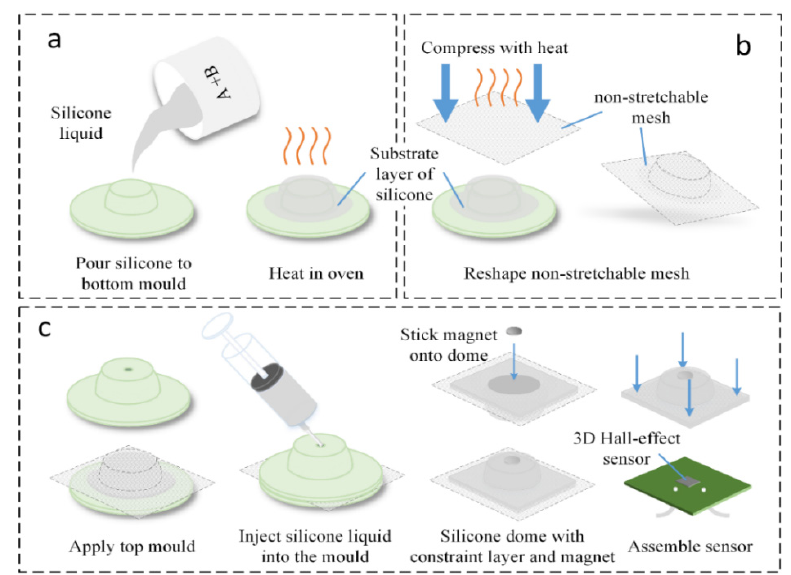
Figure 2. Fabrication of the soft sensor: ( a ) the bottom elastomeric layer is formed by pouring pre-polymer silicone rubber onto the bottom mold and then curing by heating in oven at 45 ℃ for 15 min. ( b ) Thermal pre-shaping of the inextensible strain-limiting fabric layer. ( c ) Fabrication of the top layer by mold-casting and assembly of the dome onto the three-dimensional (3D) Hall-effect sensor PCB.